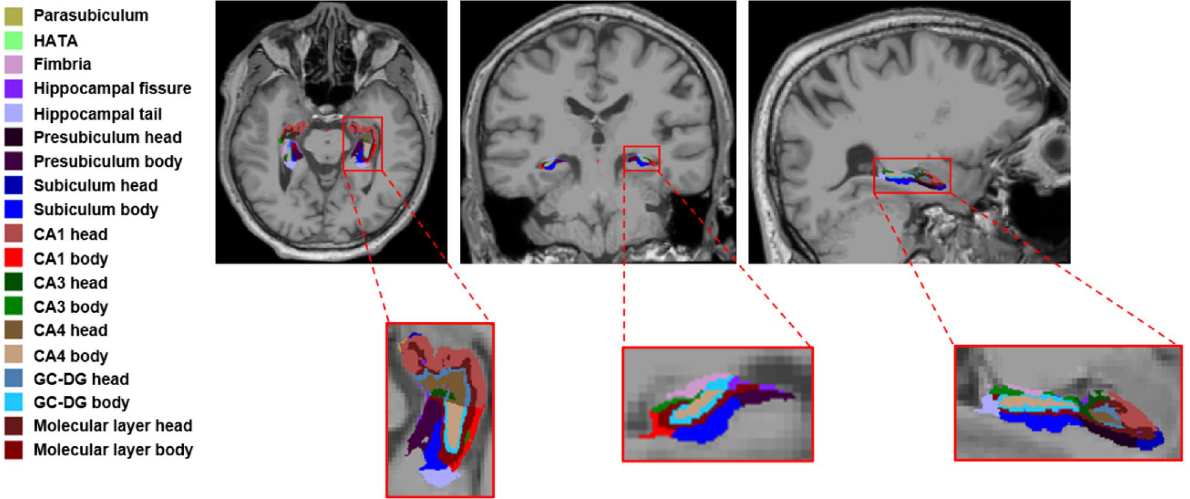
Figure 1. Hippocampal subfield segmentation. CA cornus ammonis, GC-DG granule cell layer of dentate gyrus, HATA hippocampus-amygdala transitional